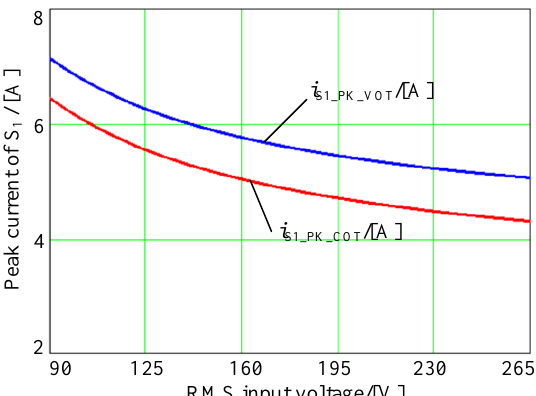
Figure 10. Comparison of the maximum peak current of S 1 under different RMS input voltage .